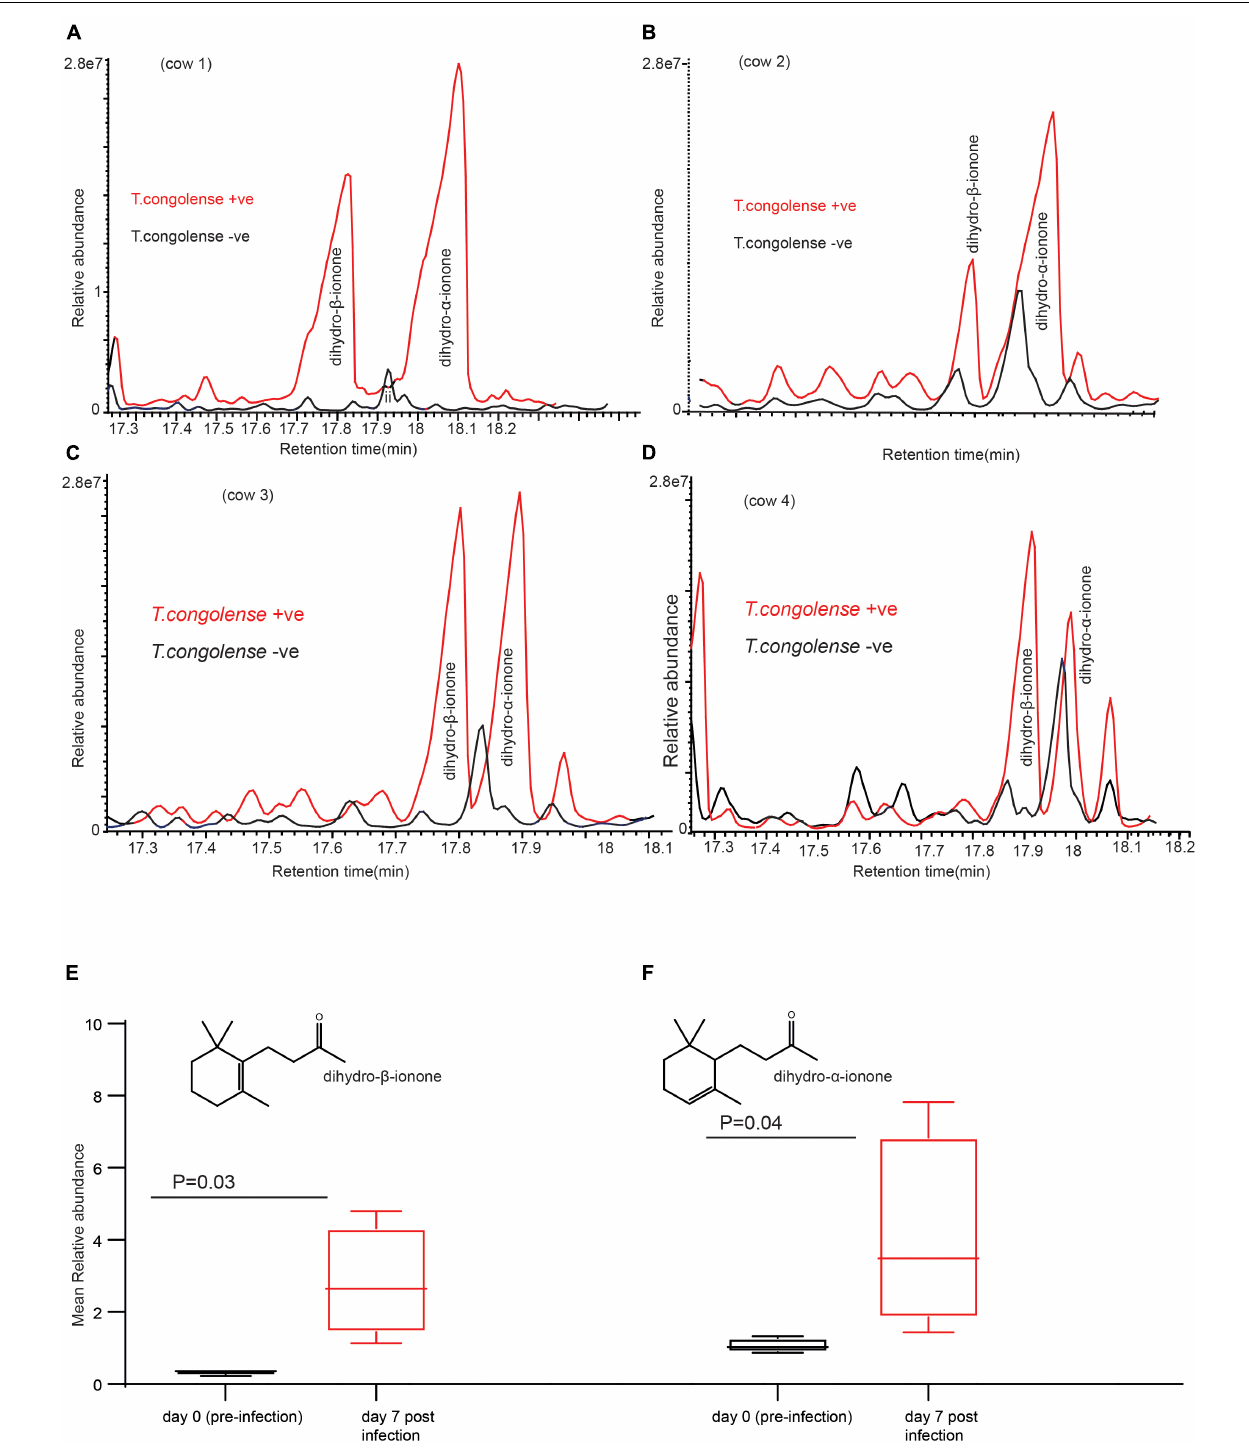
FIGURE 3 | Trypanosoma congolense infection induced dihydro- β -ionone in urine metabolites. (A–D) GC-MS profiles showing dihydro- β -ionone and dihydro- α -ionone levels in T. congolense- uninfected and infected cows, and (E) graph showing the significant change in abundance of dihydro- β -ionone due to T. congolense infection (F) . Graph showing the significant change in a relative abundance of dihydro- α -ionone due to T. congolense infection. Y -axis in (A–D) is the area of the peak, which reflects the amount of a given compound. The size and area of the component peak are proportional to the amount of the component reaching the detector. X -axis in (A–D) is retention time in minute, which is a measure of the time taken for a compound to pass through a chromatography column. It is calculated as the time from injection to detection.